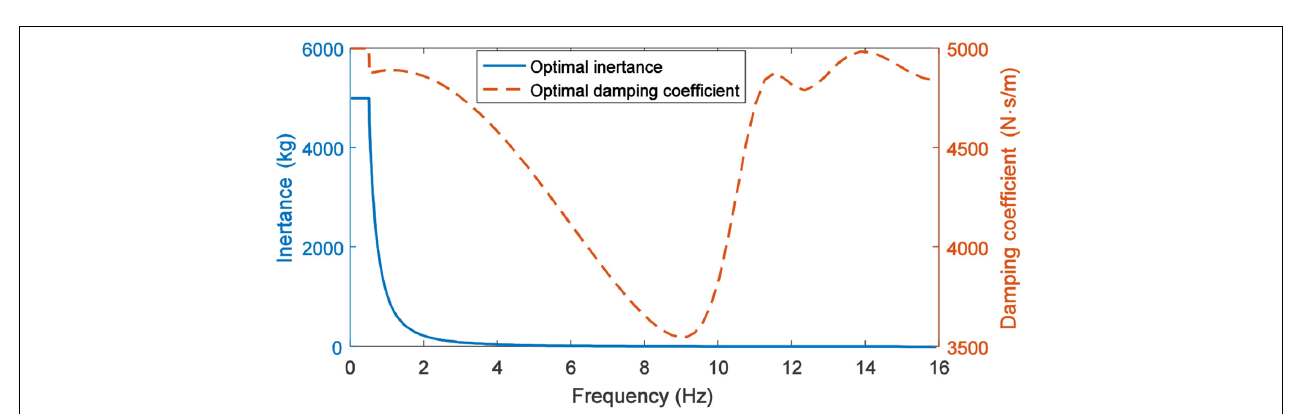
FIGURE 12 | Optimal inertance and optimal damping